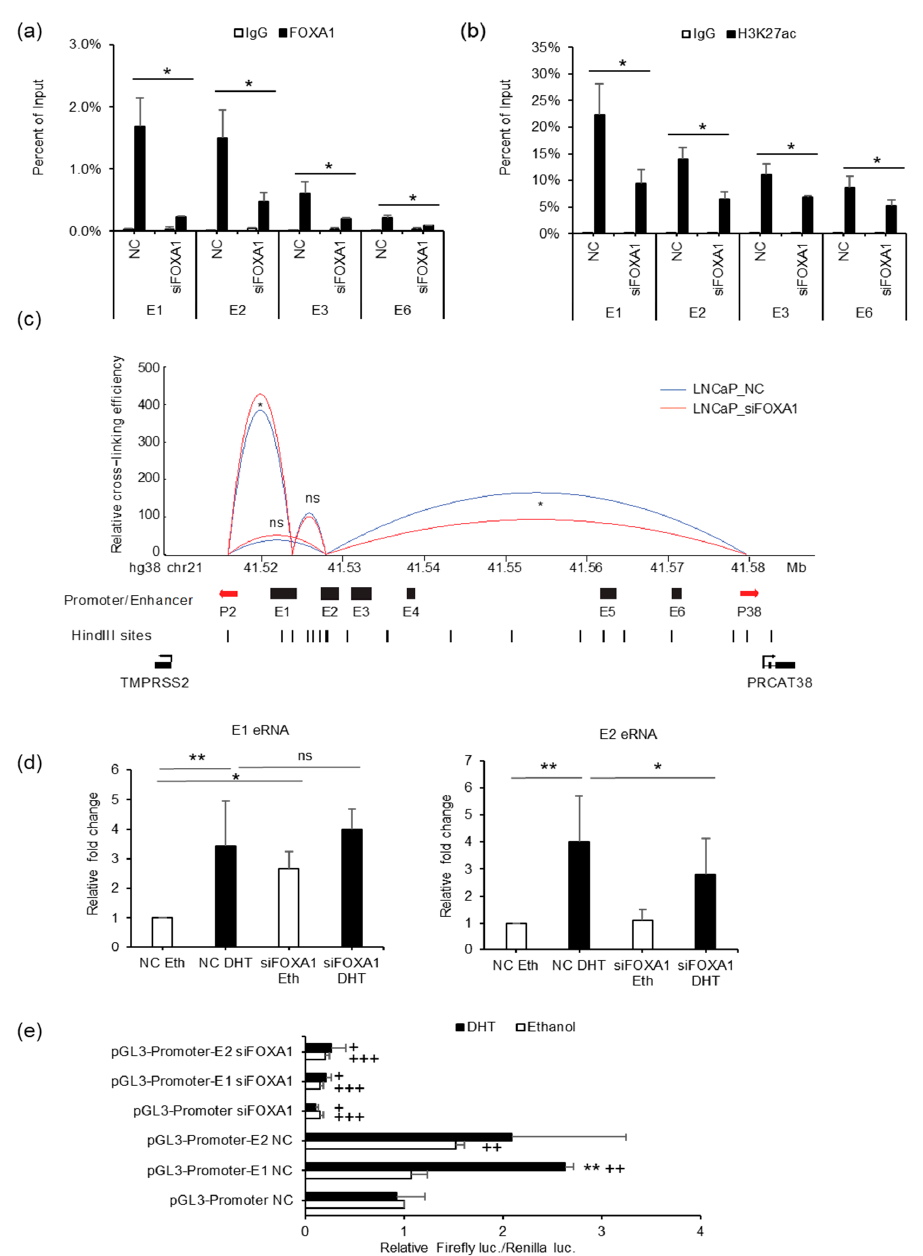
Figure 6. FOXA1 is required for enhancer activity and chromatin looping between enhancers and promoters of TMPRSS2 and PRCAT38 . ( a , b ) ChIP-qPCR in LNCaP cells before and after FOXA1 knockdown showing FOXA1 and H3K27ac enrichment over the enhancer regions. ( c ) 3C-qPCR analysis of the looping between enhancers and promoters before and after FOXA1 knockdown in LNCaP (peak values of the loops are the mean of 3 biological replicates). ( d ) eRNA transcription from enhancers E1 and E2 before and after FOXA1 knockdown in LNCaP. ( e ) Dual-luciferase reporter assay to determine enhancer activity of E1 and E2 before and after FOXA1 knockdown in LNCaP. Data are shown as the mean ± SD (n = 3); * indicates a significant di ff erence between vehicle and DHT treatment, + indicates significant di ff erence between respective construct and pGL3-promoter. * /+ : P < 0.05, ** /++ : P < 0.01, ns: not